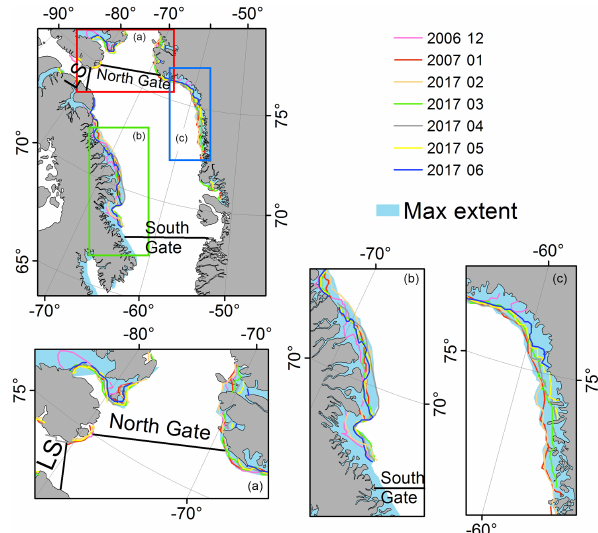
Figure 5. Monthly mean fast ice extent obtained from the CIS map for the period from December 2016 to June 2017. Typical fast ice regions (a, b, and c) in Baffin Bay are zoomed to distinguish the fast ice extent during different periods. The fluxgates are also